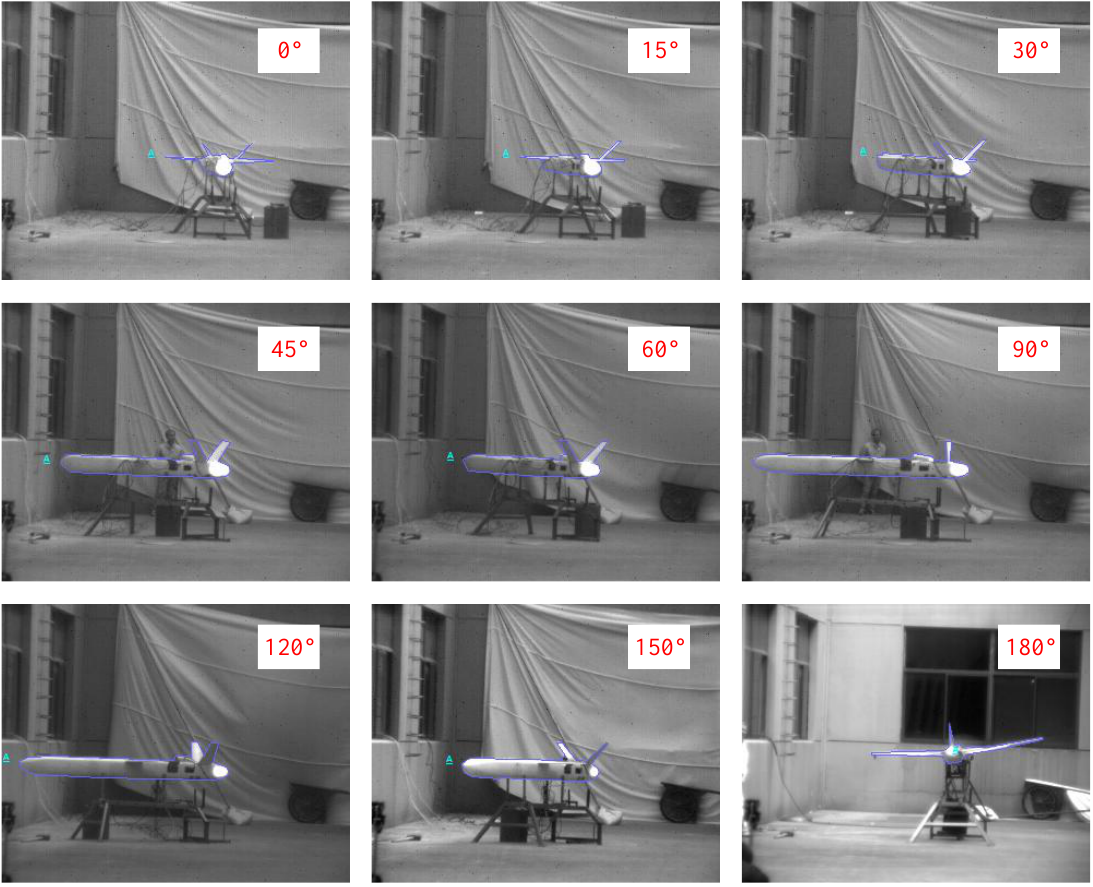
Figure 15. UAV images captured by the SWIR camera at different observation angles.